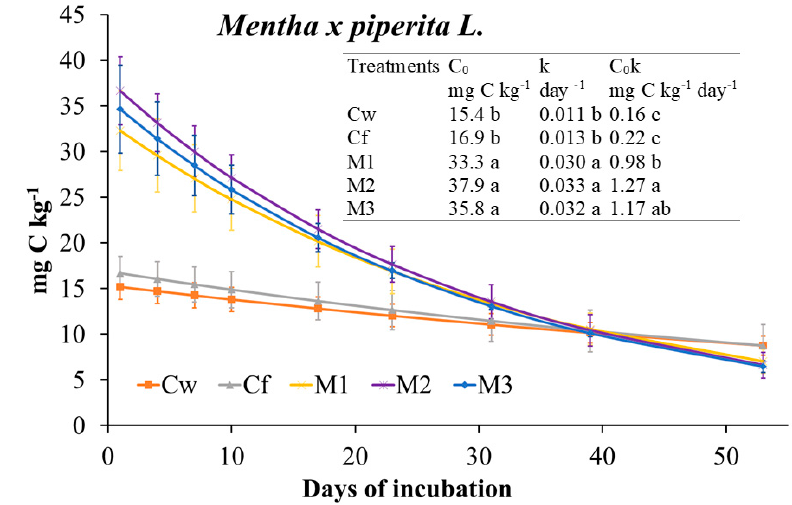
Figure 4. Microbial respiration rate fitted to the exponential first order decay function (Mineralized C = C 0 e − kt ) and derived parameters (C 0 , biological available C; k, turnover constant rate; C 0 K, initial potential rate of C mineralization) determined on soil treated with Mentha × piperita L. essential oil (EO) applied by irrigation. Treatments were: Cw (no Fitoil and EO application), Cf (0.03 µ L Fitoil g − 1 of soil and no EO application), T1 (0.03 µ L Fitoil g − 1 of soil and 0.31 µ L EO g − 1 of soil), T2 (0.03 µ L Fitoil g − 1 of soil and 0.67 µ L EO g − 1 of soil), and T3 (0.03 µ L Fitoil g − 1 of soil and 0.93 µ L EO g − 1 of soil). Reported results are means ( n = 4). Bars indicate the standard deviations. Lower case letters indicate significant di ff erences among treatments.